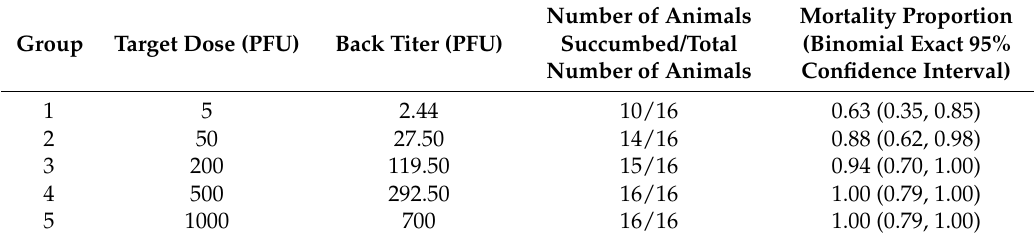
Table 3. Mortality comparison by target dose.